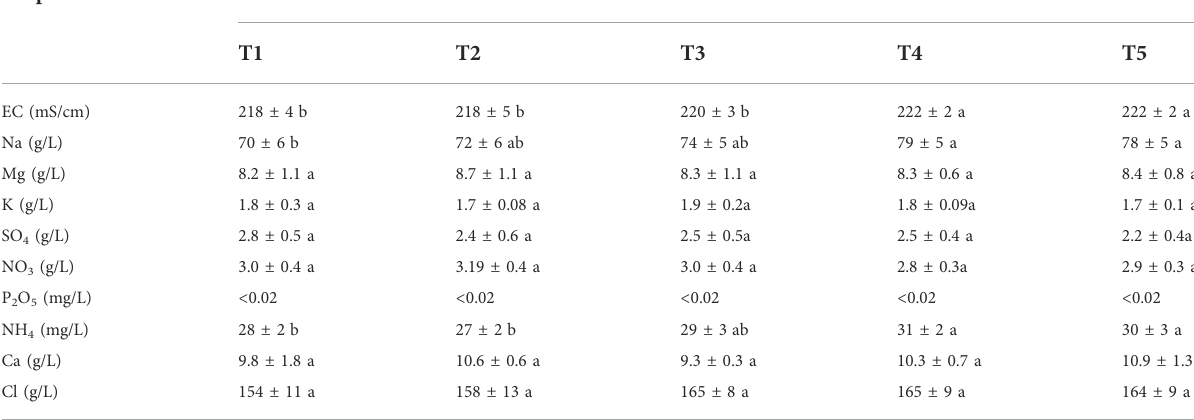
TABLE 5 EC, salts, and nutrients contents of leachate of Sed El Masjoune soil for different treatments. In a line series, same letters indicate no signi fi cant differences among treatments ( p < 0.05, S-N-K ‘ s